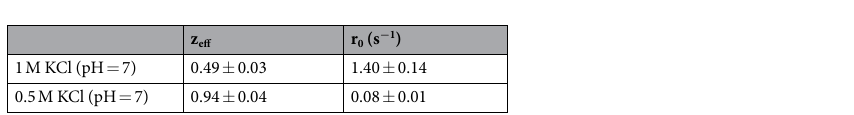
Figure 6. The kinetics description of PAMAM-G1 – α -HL interactions in 0.5 M KCl, at pH = 7. Representative histograms of the inter-event ( τ on ) (panel a) and blockade duration intervals ( τ off ) (panel b) characterizing the PAMAM-G1 – α -HL interactions recorded at Δ V = + 100 mV, in 0.5 M KCl, at pH 7, with the trans -side added dendrimer (500 μ M). The histograms were fitted with mono-exponential functions, and corresponding reaction rates describing the PAMAM-G1 – α -HL interactions were derived. The dendrimer capture rate by the nanopore (rate on , ‘ ⬓ ’ – ‘down-filled squares’), and the dissociation rate (rate off , ‘ ⬒ ’ – ‘up-filled squares’) are shown in panel c. The voltage-dependence of inter-event times ( τ on ) and blockade durations ( τ off ) are shown in panels d (‘ ⬓ ’ – ‘down-filled squares’) and e (‘ ⬒ ’ – ‘up-filled squares’).